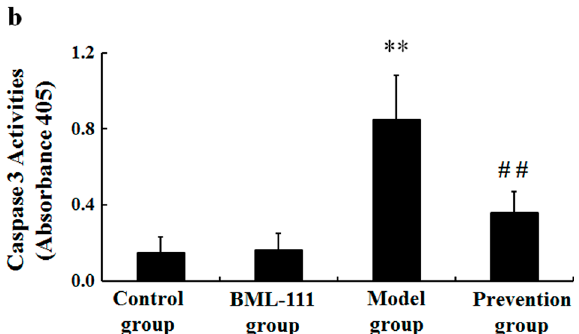
Figure 3. BML-111 inhibited LPS/ D -GalN induced TNF- α and caspase 3 activity; ( a ) the levels of TNF- α were measured at 1.5 h after LPS/ D -GalN administration in serum and hepatic tissues, using ELISA kits; ( b ) the relative activities of caspase 3 in hepatic tissue at 6 h after being challenged with LPS/ D -GalN. ** p < 0.01 compared with the control group, ## p < 0.01 compared with the model group ( n = 6). 2.4. BML-111 Inhibited LPS/ D -GalN-Induced COX-2 and IL-1 β . As shown in Figure 4, in the model rats, LPS/ D -GalN increased the amounts of COX-2 and IL-1 β , but the effects were reversed in BML-111-pretreated rats.